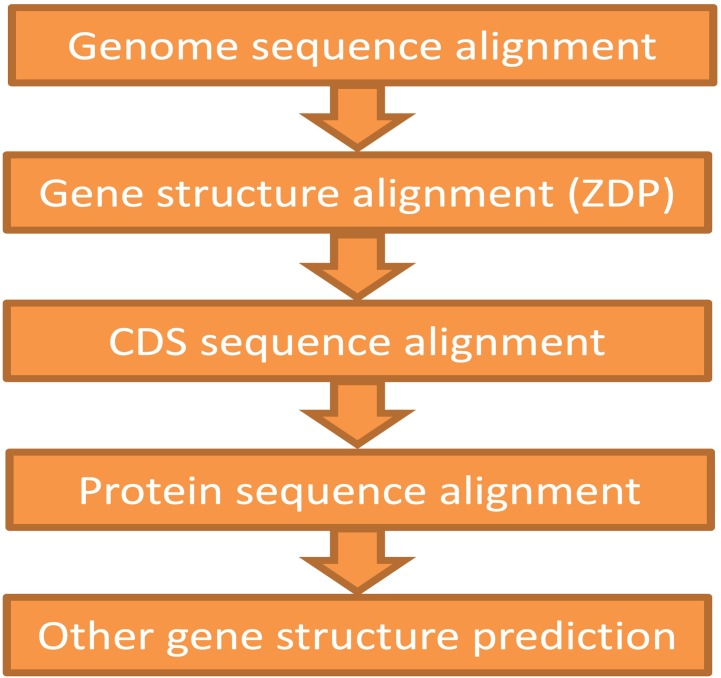
Schematic showing the pipeline for the protein-coding gene annotation of the non-reference genome. The annotation of upstream function would be supplemented with the downstream modules.